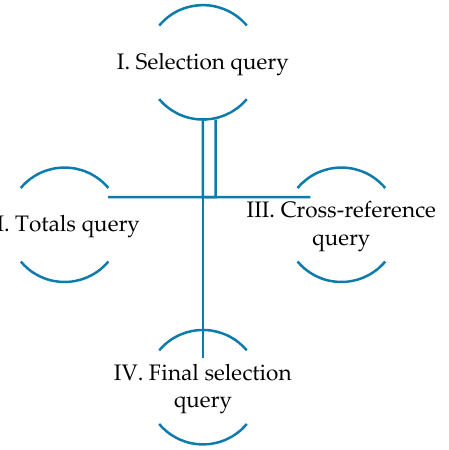
Figure 5. Procedure to create queries in the database. Source: Own preparation.